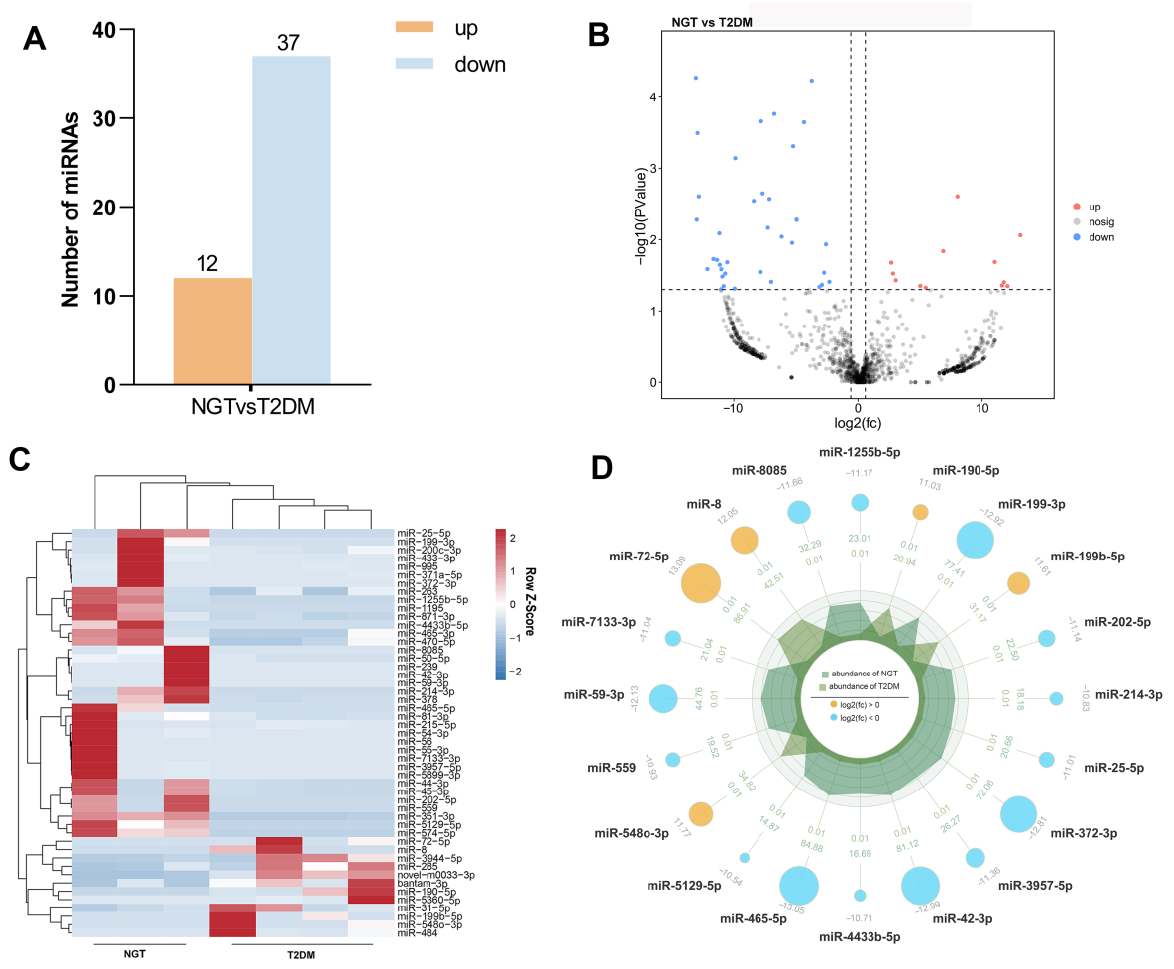
Figure 1. The expression profiles of miRNAs. ( A ) The column chart of the number of statistical DEmiRNAs; ( B ) the volcano plot displays the distribution of DEmiRNAs; ( C ) hierarchical clustering analysis of DEmiRNAs between T2DM group and NGT group were showed by the heat map. Red color represents up-regulated miRNAs, and the blue color represents down-regulated miRNAs; ( D ) the radar plots display the distribution of DEmiRNAs and the size of the circle indicates the log2 (FC). DEmiRNAs, differentially expressed microRNA; NGT, normal glucose tolerance; Log2 (FC), log2 (fold change); T2DM, Type 2 Diabetes.